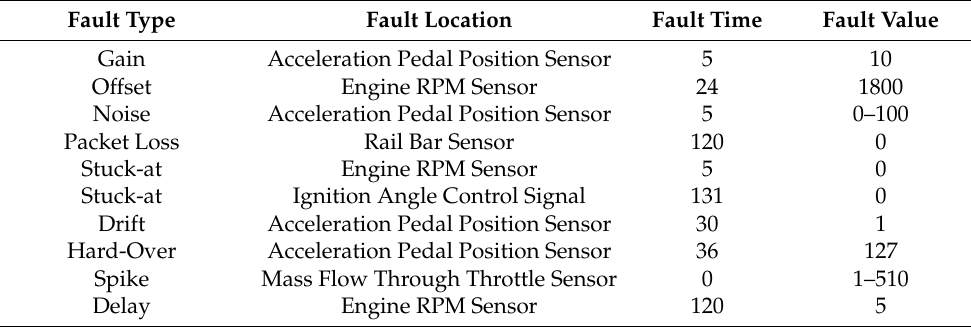
Figure 9. Driving cycle in dSPACE ControlDesk. Table 5. Configuration of permanent single fault injector.